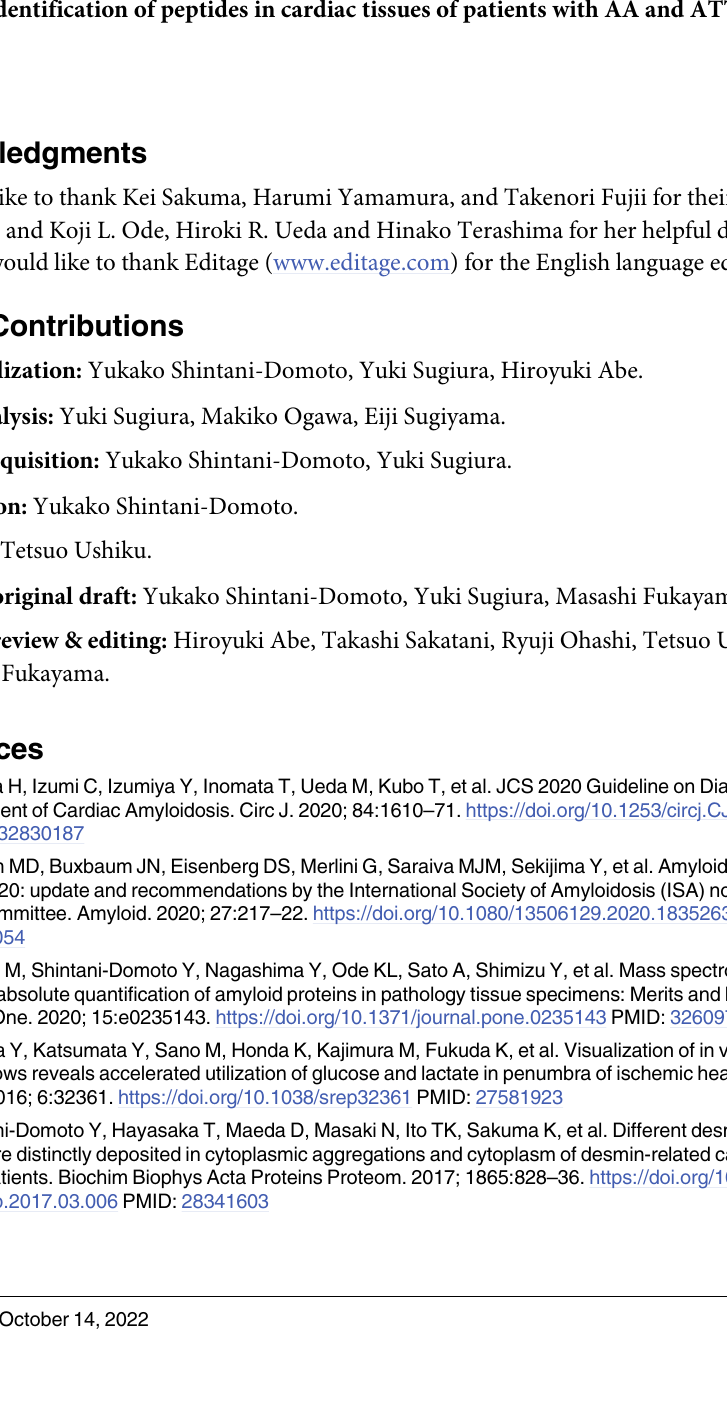
S3 Fig. Schematic representation of the proteolysis in cardiac tissue of patients with AA amyloidosis. C-terminal side peptides, SAA47-62, SAA 48–62, and SAA 63–67 may be degraded by endogenous proteases and spread to the surrounding tissues. (TIF) S4 Fig. SAA harbors cleavage sites for cathepsins and matrix metalloproteinases. Four regions, SAA 2–15, SAA47-62, SAA 48–62, and SAA 63–67 as detected by MALDI-TOF MS in this study, are shown in the box. S1 Table. Identification of peptides in cardiac tissues of patients with AA and ATTR amy-